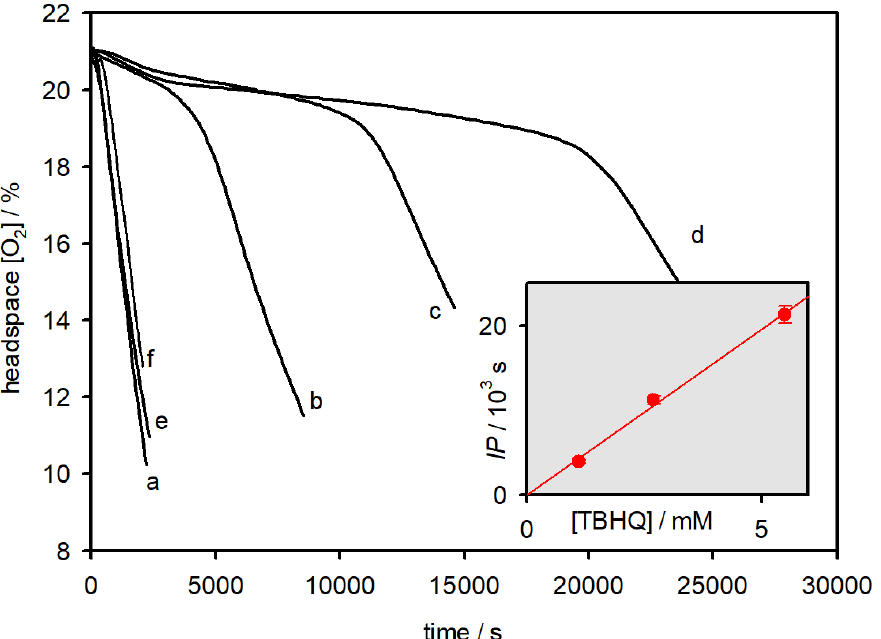
Figure 2. O 2 consumption during the autoxidation of SSO at 130 °C without antioxidants ( a ) or in the presence of 10 : 0.02% ( b ), 0.05% ( c ) and 0.1% ( d ), or 13 , 0.1% ( e ). O 2 consumption of peroxidized SSO in the presence of 10 , 0.02% ( f ). The inset reports the relationship between the 10 concentrations and IP . Some error bars are smaller than the symbol